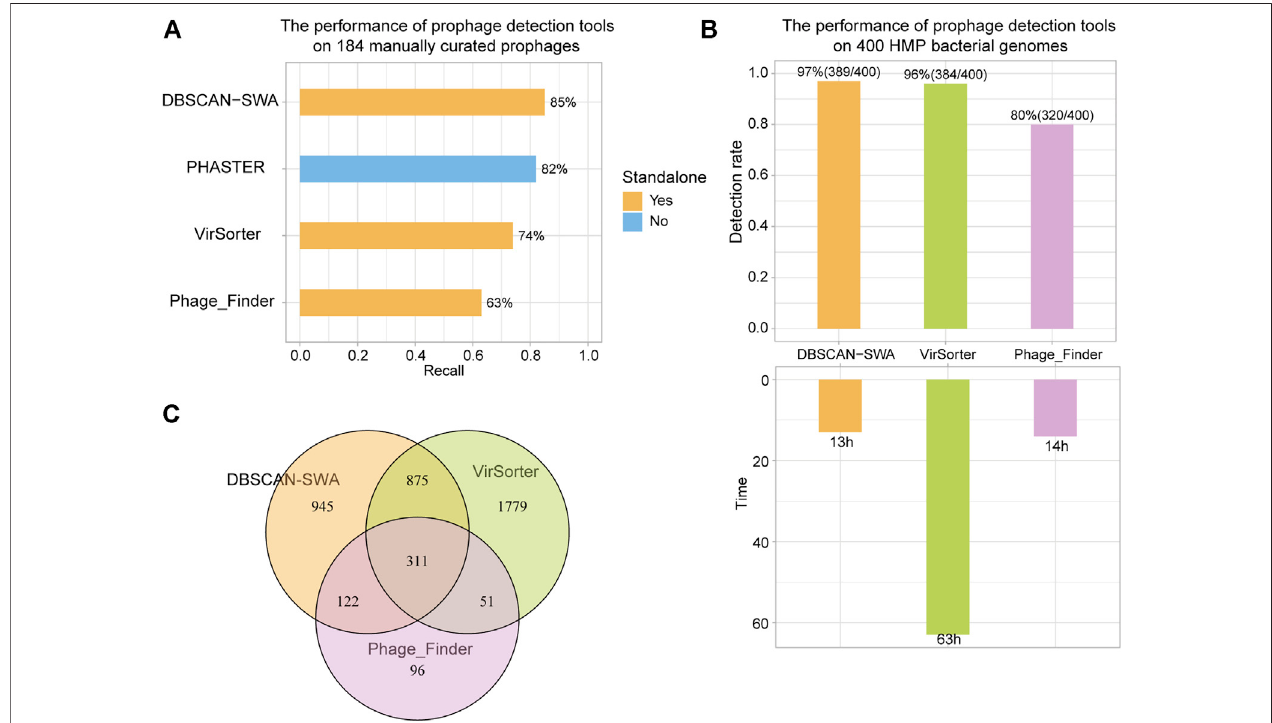
FIGURE 3 | Recall of prophage detection tools for 184 manually curated prophages and 400 HMP bacterial genomes. (A) Recall of detection results for 184 manuallycurated prophages using DBSCAN-SWA, PHASTER, VirSorter, and Phage_Finder. (B) Detection rateand timeofpredicting prophages for400HMP bacterial genomes. (C) Shared prophages of DBSCAN-SWA, Phage_Finder, and VirSorter for 400 HMP bacterial genomes.